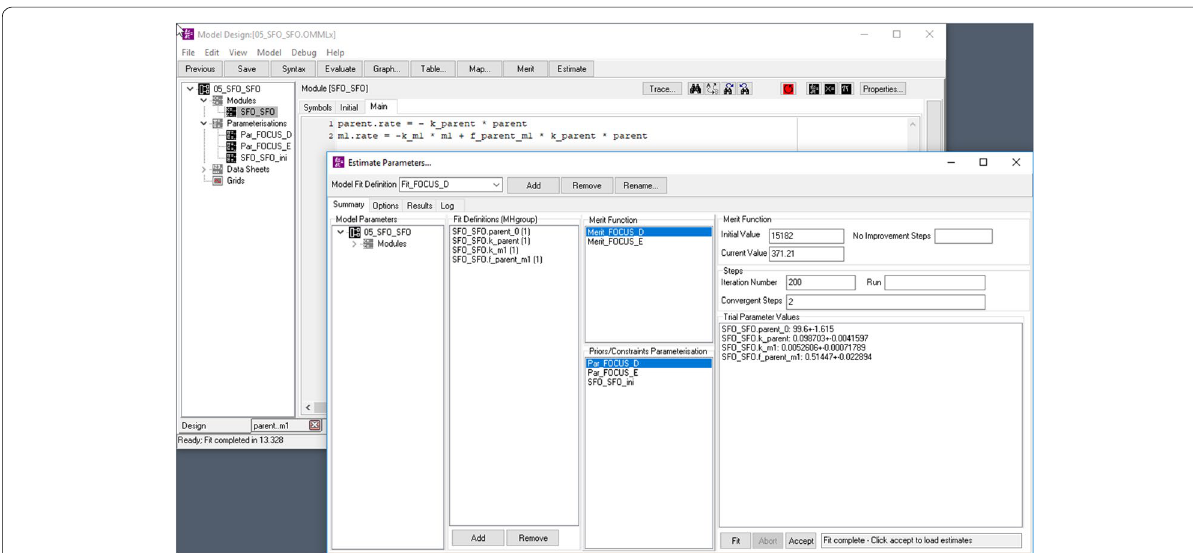
Fig. 5 Screenshot of OpenModel 2.4.2 The script based model definition is shown in the main window on the left and the parameter estimation window is shown on the